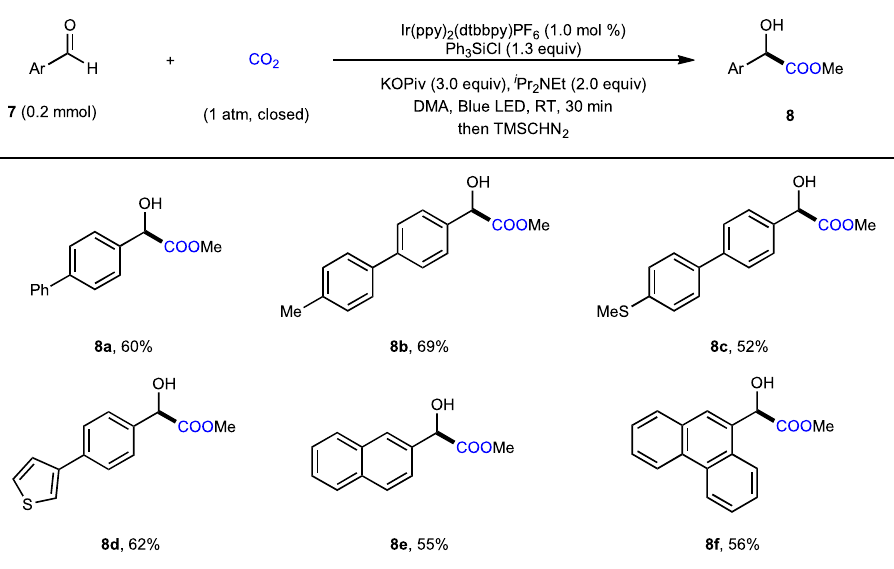
Fig. 7 Substrate scope of aryl aldehydes. Isolated yields of corresponding methyl esters are